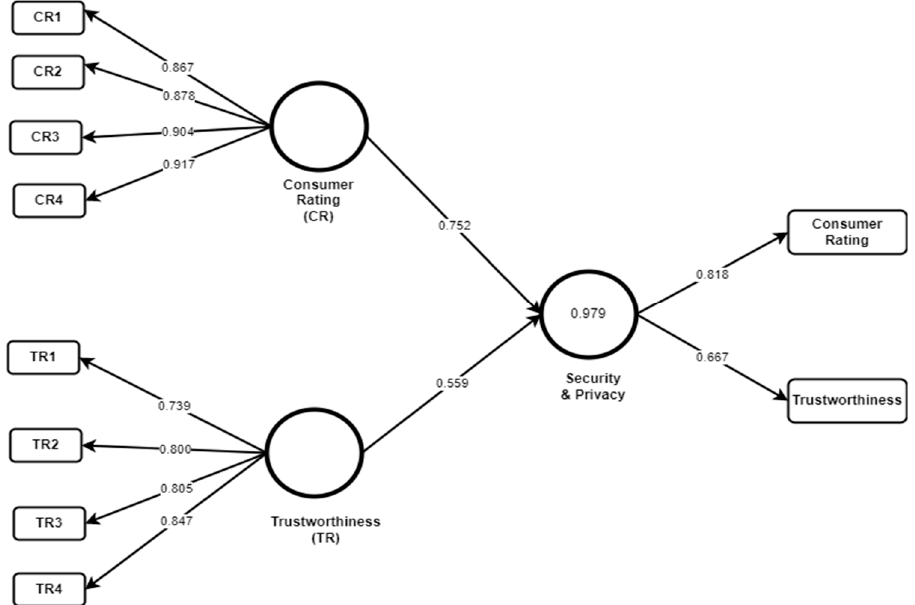
Figure 7. OUNAS model.